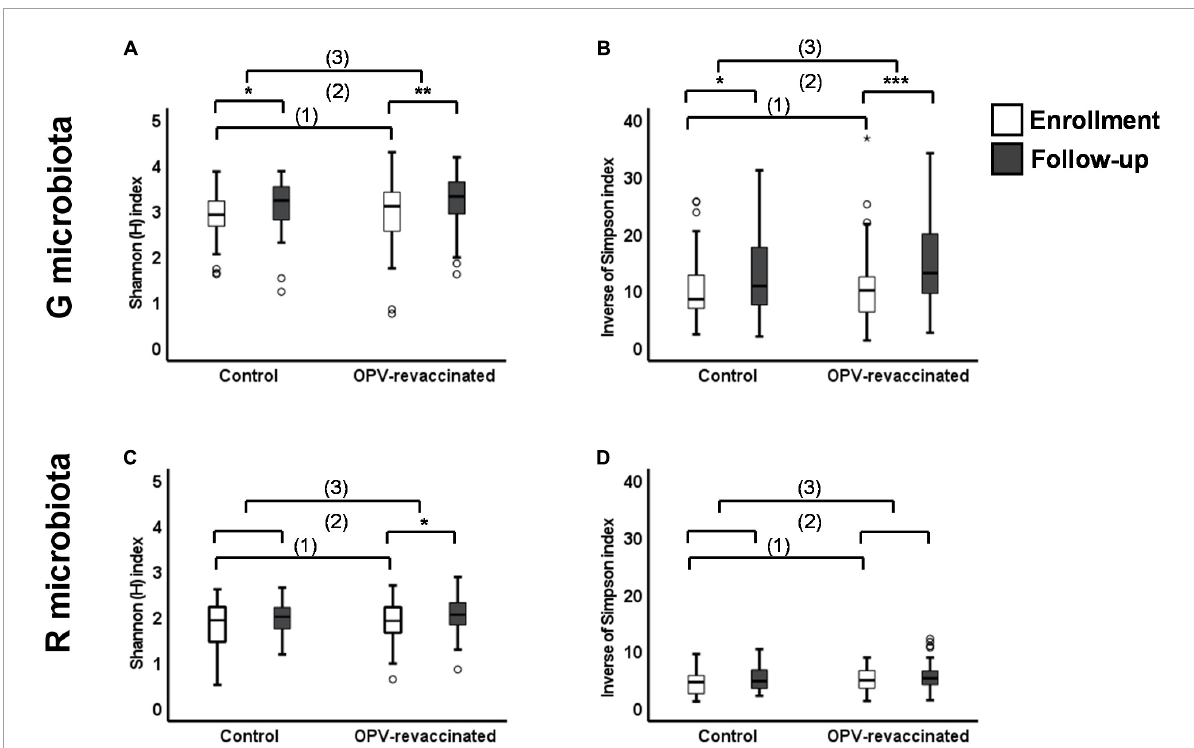
FIGURE2 Changes in alpha-diversity over time in G and R microbiotas of infants. Shannon (H) index (A,C) and Inverse of Simpson index (B,D) values were compared: (1) between Control and oral polio vaccine (OPV) revaccinated infants at enrollment without significant differences ( p > 0.05) for any comparisons, (2) within each group over time with significant differences for G microbiota in both groups [ (A) Control p = 0.038 and OPV revaccinated p = 0.001; (B) Control p = 0.047 and OPV revaccinated p < 0.001] and R microbiota in OPV revaccinated [ (C) OPV revaccinated p = 0.01], and (3) the magnitude of changes over time was compared between groups without significant differences for any comparisons. * p < 0.05; ** p < 0.01; *** p < 0.001; the absence of asterisks for any comparisons indicates that there are no significant differences. Mann–Whitney U test was used for comparisons between groups and paired Wilcoxon signed rank test was used for comparisons within groups over